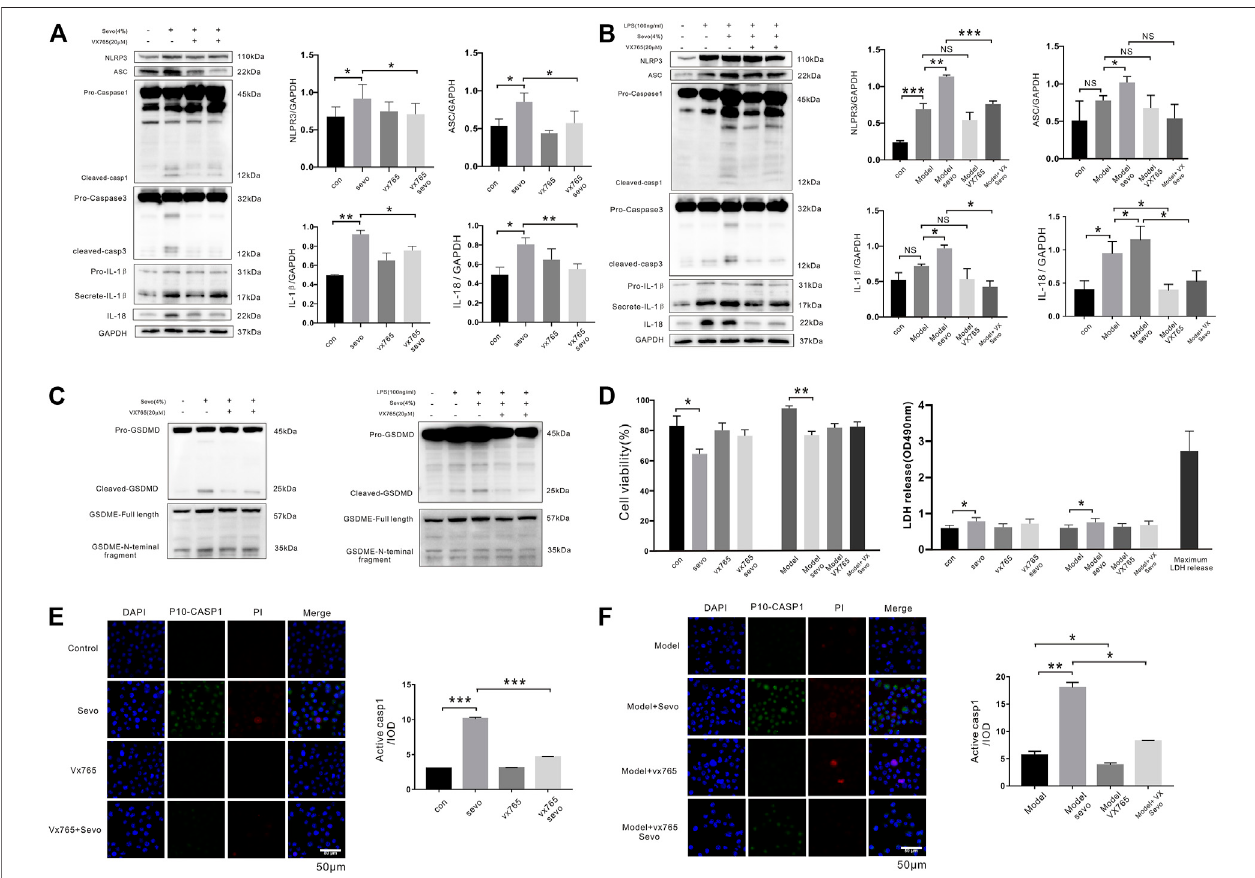
FIGURE 2 | Sevo fl urane promotes caspase-1-dependent pyroptosis in BV2 microglia (A) . Cleaved caspase-1 and caspase-3, IL-1 β , and IL-18 levels were detected by Western blotting analysis in BV2 microglia exposed to 4% sevo fl urane for 6 h (B) . Western blotting analysis of caspase-1, caspase-3, IL-1 β , and IL-18 induced by sevo fl urane in BV2 cells pretreated with 100 ng/ml of lipopolysaccharide (LPS). (C) Pyroptosis-related proteins (gasdermin D (GSDMD) and gasdermin E (GSDME)) were detected by Western blotting analysis induced by sevo fl urane in BV2 cells. (D) Cell Counting Kit-8 (CCK-8) and lactate dehydrogenase (LDH) releaseassaysofcellviabilityandLDHactivityinBV2cells. (E) .FAM-FLICAcaspase-1assaysofcleavedcaspase-1(green),propidiumiodide(PI)(red),andDAPI(blue)in BV2cells.Scalebar:50 μ m.Cleavedcaspase-1 fl uorescenceintensitywascalculatedastheiod. (F) .FAM-FLICAcaspase-1assaysofcleavedcaspase-1(green)inBV2 cells. Scale bar: 50 μ m. *** p < 0.001, ** p < 0.01, * p <